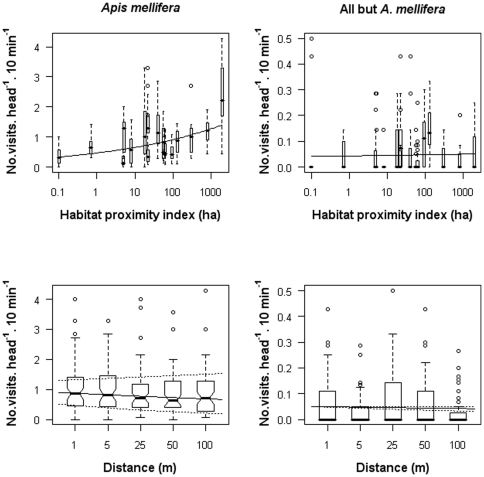
Effects of proximity to the sierras and distance to the field margins on visitation frequency.Box plots of frequencies of insect visits to sunflower heads in relation to proximity to the sierras (upper panels) and distance to the field margin (lower panels) for Apis mellifera (left panels) and “native insects” (right panels). Solid lines depict the predicted partial regression curves. In the lower panels, the lower and upper dotted curves depict the expected distance-to-the-margin effect for the most and least isolated sunflower field, respectively, based on the most complete generalized linear model that includes the interaction between the two habitat factors.